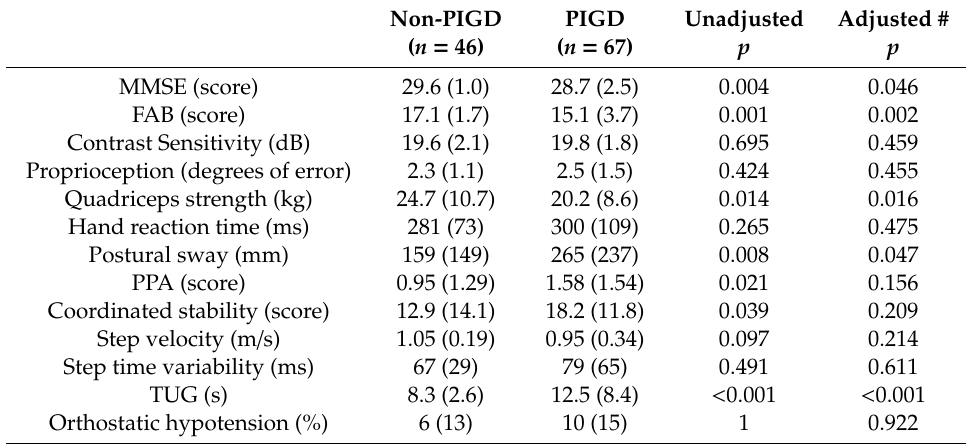
Table 2. Cognitive, sensorimotor, balance, gait, mobility and cardiovascular characteristics for the non-PIGD and PIGD groups. Data are presented as mean (SD) unless stated otherwise. Non-PIGD